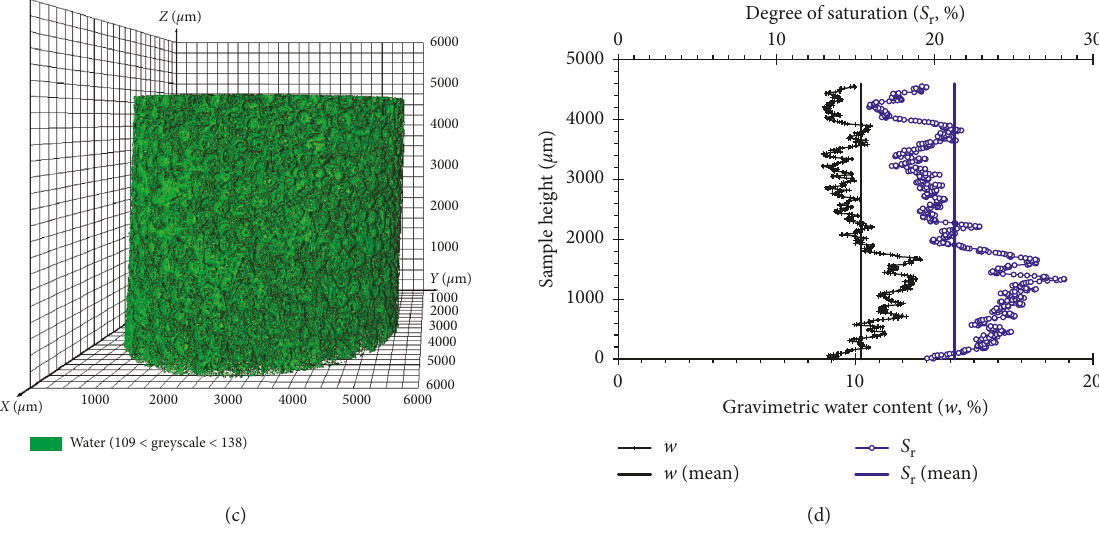
Figure 6: 3D reconstruction and water distribution within the compacted BioSpec glass beads. (a) 3D reconstruction. (b) Enlarged view. (c) Segmented water phase. (d) Profile of water content and degree of saturation.